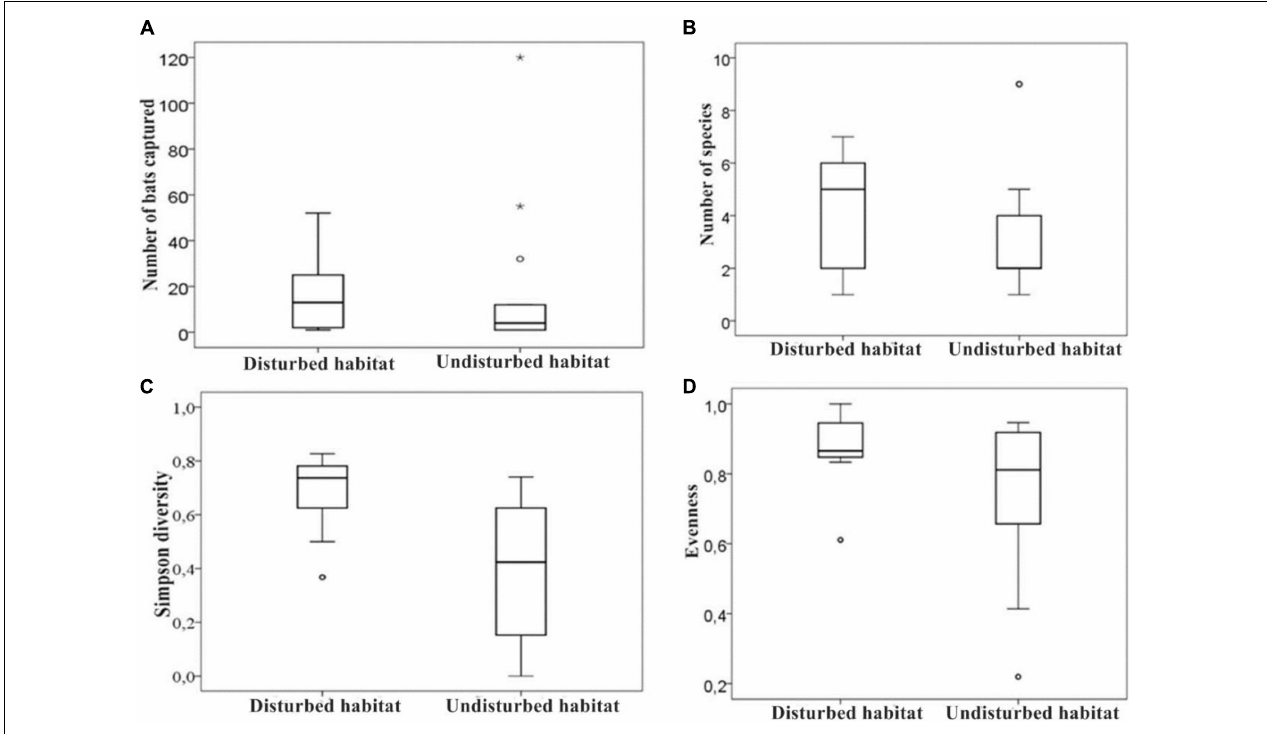
FIGURE 2 | Box plots comparing variation in abundance (A) , species richness (B) , Simpson diversity (C) , and habitat evenness (D) of bats in undisturbed and disturbed habitat sites of the Afromontane biome of western Cameroon. The small circles ( ◦ ) and asterisks (*) represents outliers and extreme outliers respectively.